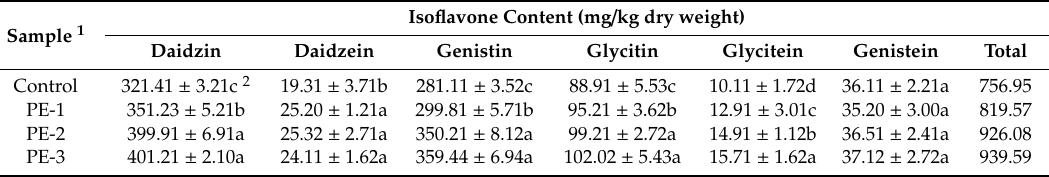
Table 5. Isoflavone content of soybean sprouts grown after seed-soaking in di ff erent concentrations of Pu-erh tea